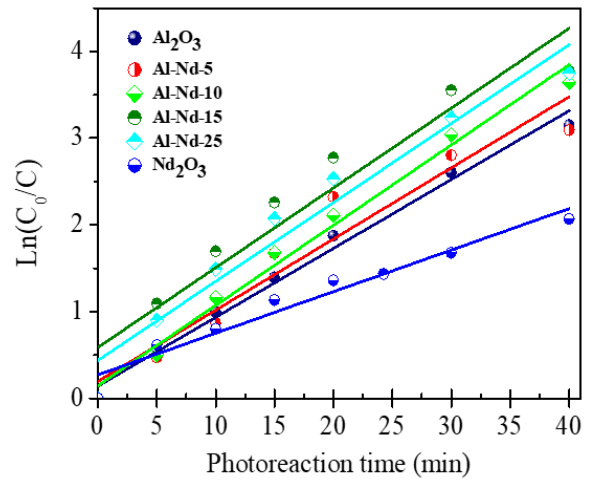
Figure 11. Ln (C 0 / C) vs. photoreaction time (t) after photodegradation of diclofenac using γ -Al 2 O 3 , Al-Nd- x binary oxide and Nd 2 O 3 . Table 2. Rate constant (k) and half-life time ( τ 1 / 2 ) in the diclofenac photo-degradation reaction using Al 2 O 3 -Nd 2 O 3 binary